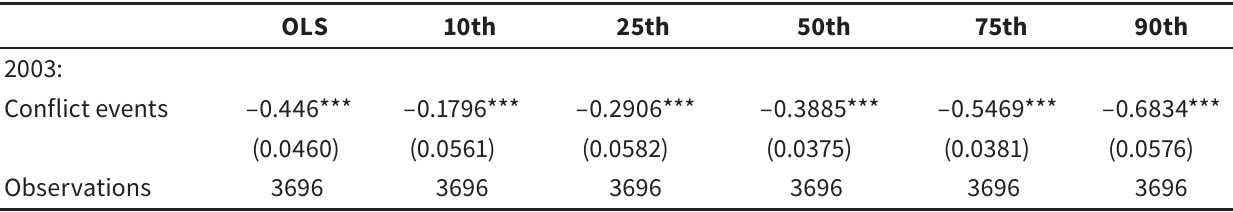
OLS and Quantile Treatment Effects of Conflict on Log Household Expenditure using Self-reported Conflict Events OLS 10th